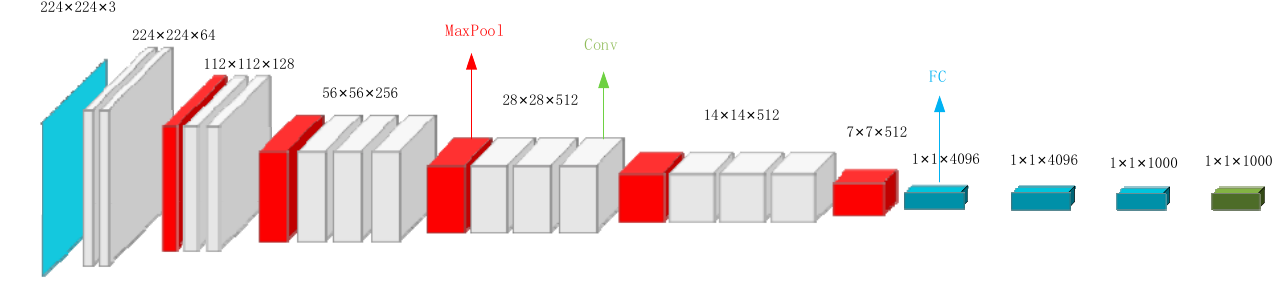
Figure 9. VGG Network